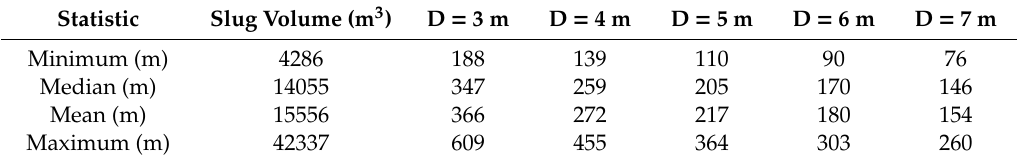
Table 4. A summary of gas slug volumes and lengths using the model of Del Bello et al. (2012) and based on gas flux and composition data acquired during Strombolian activity at Yasur volcano